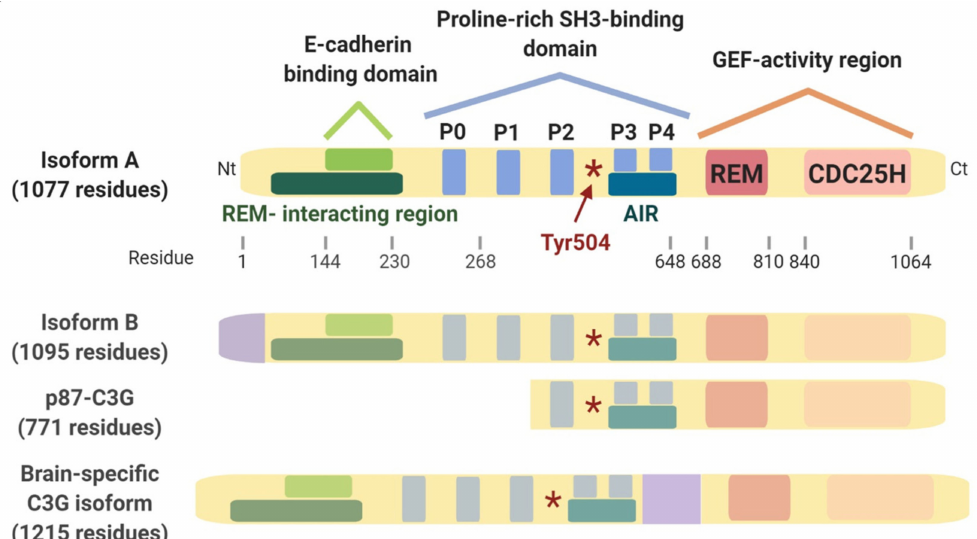
Figure 1. C3G structure and isoforms. C3G domains from N-terminal to C-terminal: E-cadherin-binding domain and REM-interacting region; SH3-binding proline-riche domains (P0–P4) and autoinhibitory region (AIR); REM and CDC25H, both responsible for C3G GEF activity. The asterisk indicates Tyr504, the most well-established residue susceptible of phosphorylation. In isoforms with more amino acids than isoform A, inserts are included in